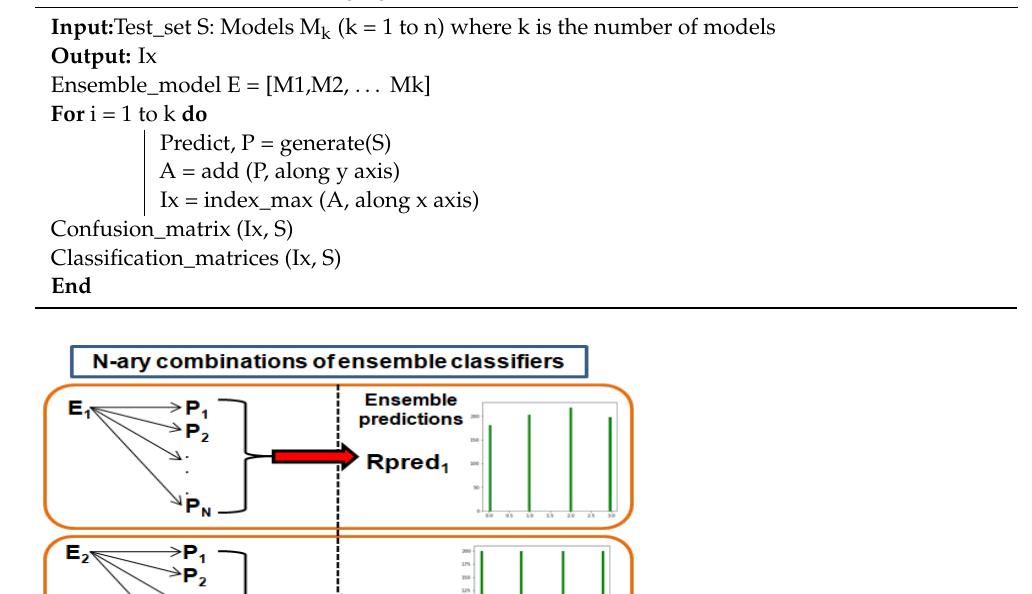
Algorithm 1: Ensemble averaging